Question: Write a single sentence explaining what this figure depicts.
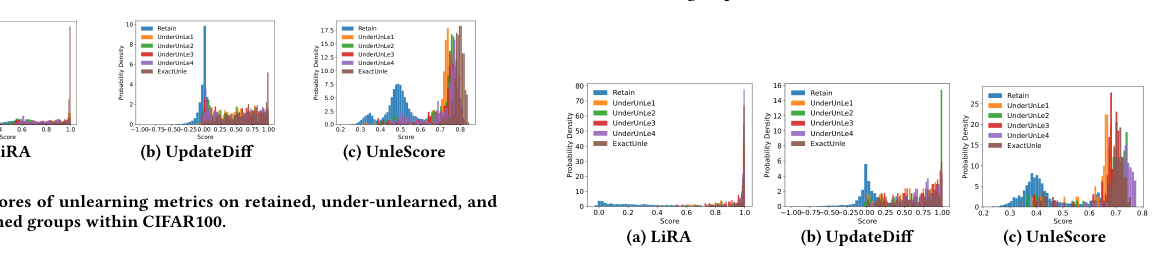
Answer: Scores of unlearning metrics on retained, under-unlearned, and exact unlearned groups within Location.